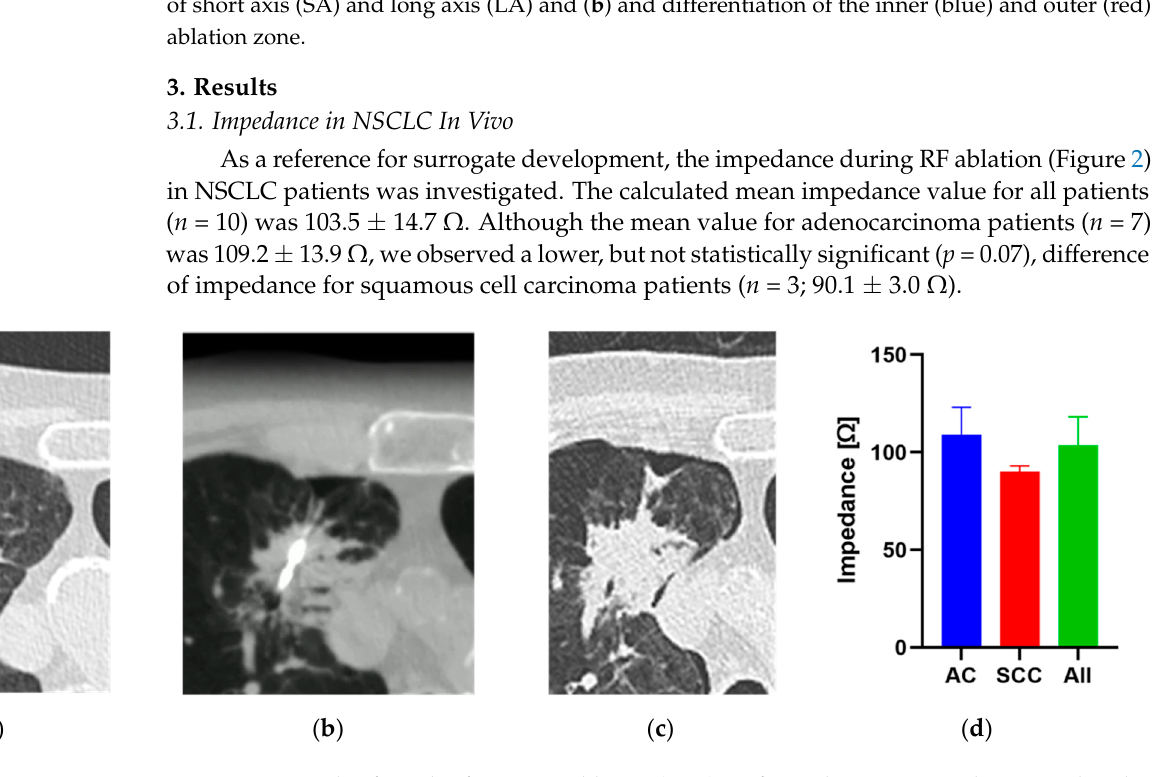
Figure 2. Example of a radio-frequency ablation (RFA) performed percutaneously using a bipolar probe. Displayed are ( a ) CT images before insertion of the RFA probe into the lung tumor mass, ( b ) the formation of necrotic tissue during RFA, ( c ) the formation of necrotic tissue after RFA, and ( d ) the recorded electrical impedance of the tumor (type: adenocarcinoma (AC) and squamous cell carcinoma (SCC)) throughout the